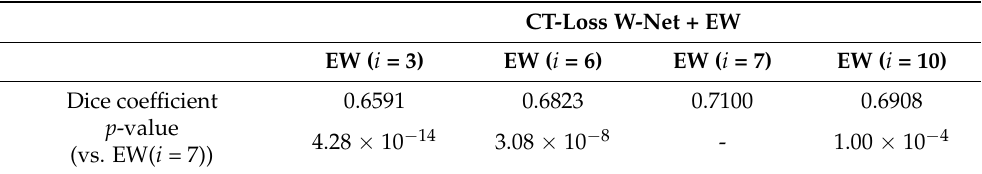
Figure 3. Examples of cervical ROI segmentation comparison. Table 3. Performance comparison for different i in encoder-weighted